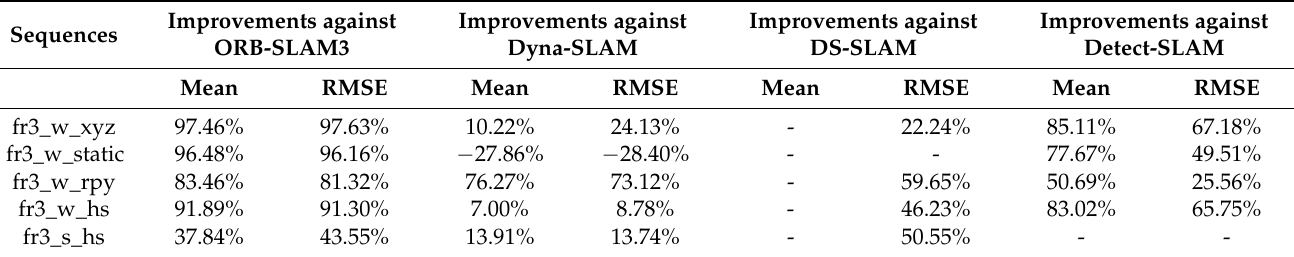
Table 2. Boosting results of SOLO-SLAM relative to other